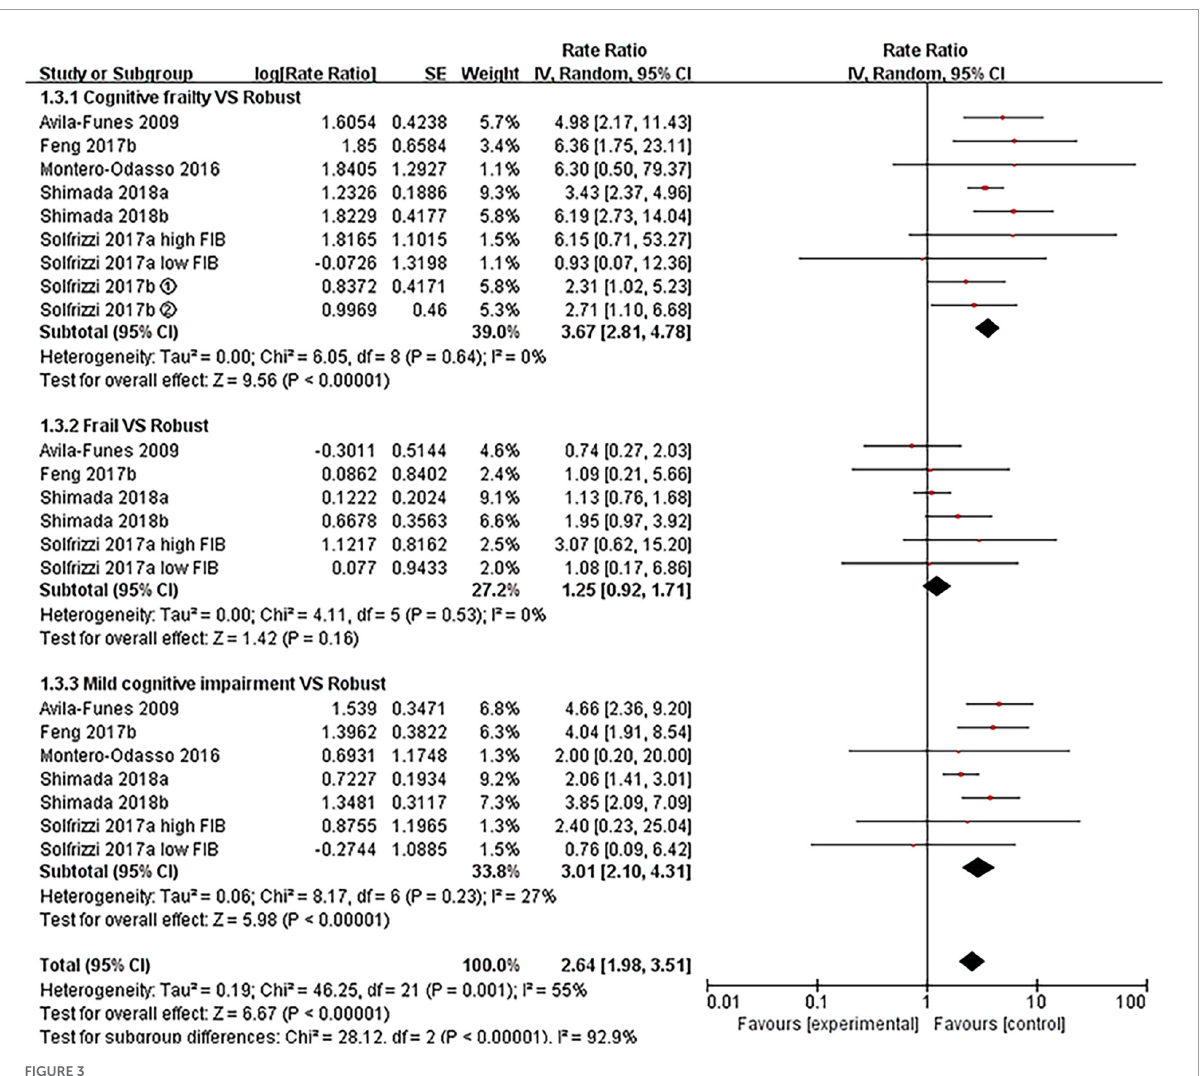
FIGURE3 Forest plot of the association between cognitive frailty, frailty, and mild cognitive impairment and incident dementia in older adults (reference group: participants were free of frailty and mild cognitive impairment), using random-effects meta-analysis. (cid:192) : follow-up 3.5 years; (cid:193) : follow-up 7 years; 95% CI, 95% confidence interval; high FIB, high fibrinogen (inflammatory); low FIB, low fibrinogen